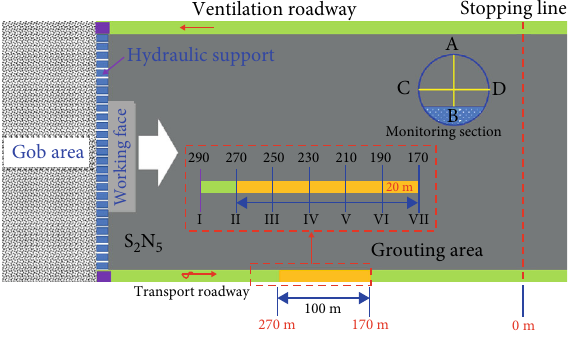
Figure 10: Overview of the testing